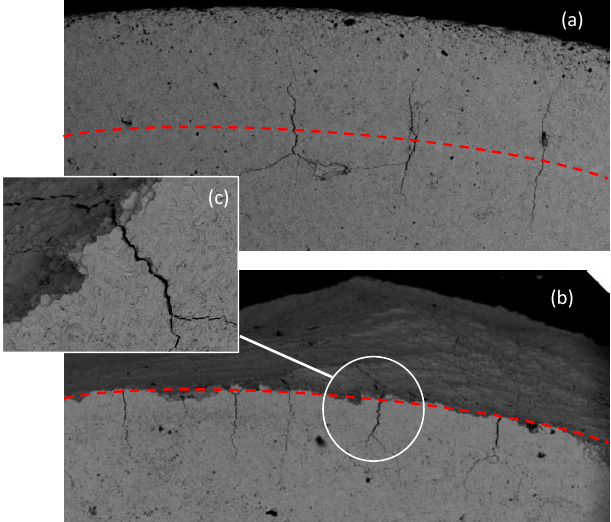
Fig. 8. Scanning Electron Microscope images of samples after the laser experiments. The dotted red line indicates the position of the peak laser intensity. (a) Sample exposed to annular beam of 300W during 10ms ; (b) Sample exposed to annular beam of 300W during 100ms ; (c) Details of the observed